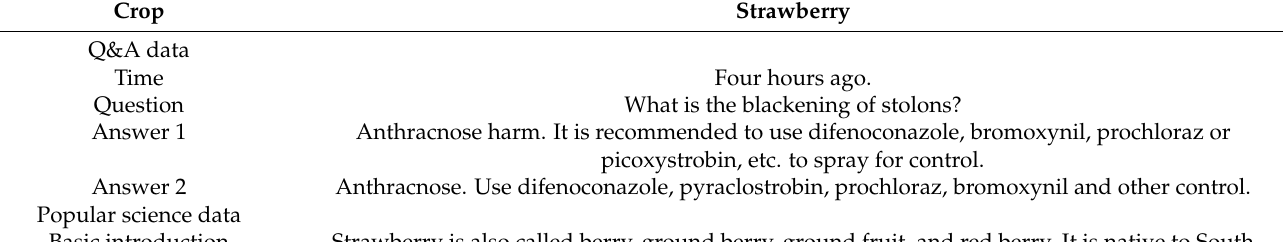
Table 2. Examples of Q&A data and popular science data.